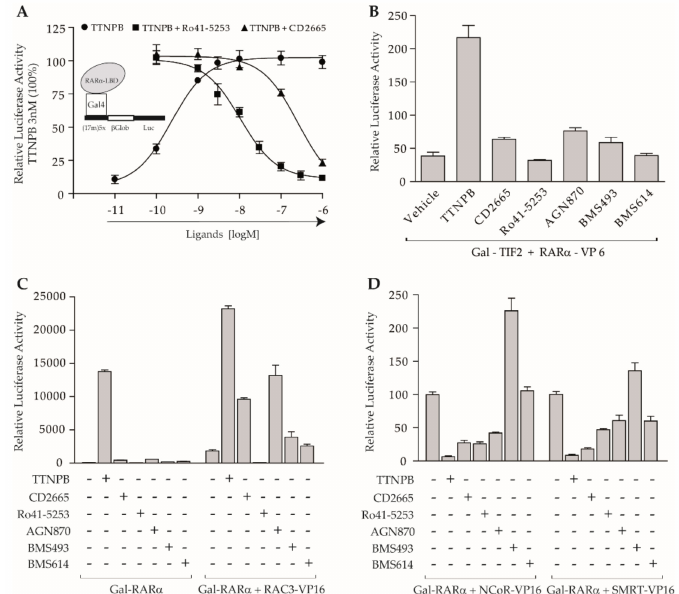
Figure 2. Co-regulator interactions define di ff erent classes of RAR α antagonists. Transient transfections were performed in COS cells; ( A ) to assess antagonistic activities of CD2665 and Ro41-5253 cells were co-transfected with (17m)5x- β Glob-Luc and Gal-RAR α . The reporter was activated by 3 nM TTNPB (100%) and increasing concentrations of CD2665 (closed triangles) or Ro41-5253 (closed squares) were added in a concentration range of 10 − 10 to 10 − 6 M, as indicated. To assess the agonistic activity of TTNPB, cells were incubated with increasing concentrations of TTNPB alone in a range of 10 − 11 to 10 − 6 M (closed circles); ( B ) mammalian two-hybrid assay with (17m)5x- β Glob-Luc and Gal-TIF2 as bait and VP16-RAR α as prey was performed to assess the influence of indicated retinoids on interaction between RAR α and TIF2; ( C ) mammalian two-hybrid assays with Gal-RAR α and RAC3-VP16 (right panel) were performed to reveal the partial agonist activity of RAR α antagonists. Gal-RAR α used alone (left panel); ( D ) mammalian two-hybrid assays with (17m)5x- β Glob-Luc and VP16-RAR α and Gal-NCoR (left panel) or Gal-SMRT (right panel) were performed to assess the influence of indicated retinoids on interaction between RAR α and CoRs (100%, basal transcriptional activity). Compounds were used at 1 µ M in all two-hybrid assays. Error bars,